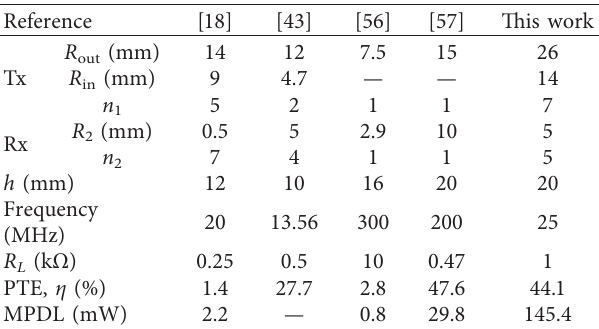
Table 5: Performance comparisons with previous works of in- ductive link WPT system for cm-sized